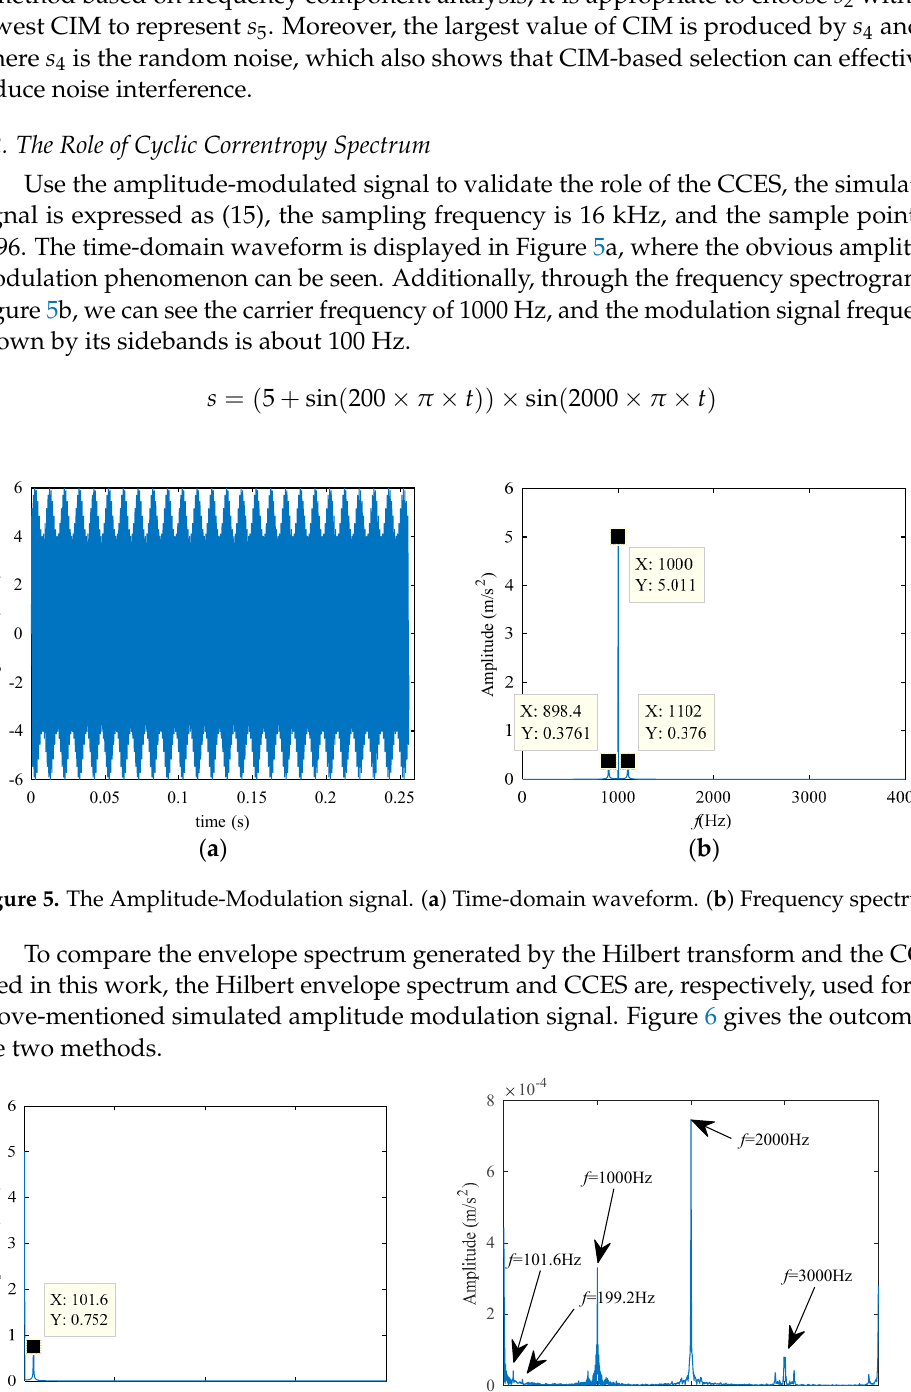
Figure 6. Envelope spectrum and CCES of the simulation signal. ( a ) Envelope spectrum. ( b )